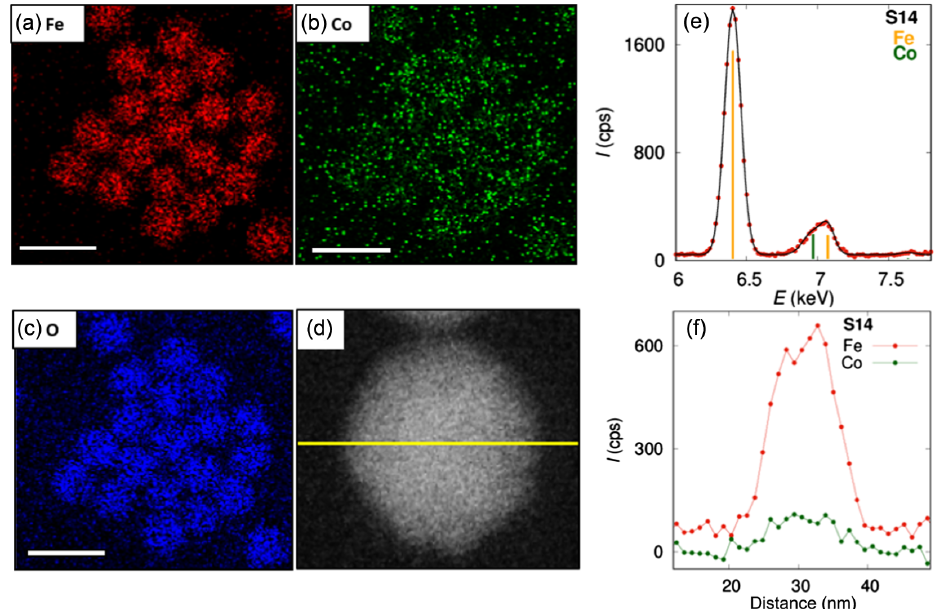
FIG. 11. (a) – (c) EDX map of the distribution of Fe, O, and Co over a region containing 19 – 20 particles (scale bars of EDX maps, 10 nm) with (e) spectra reconstructed from the indicated area. (f) EDX line scan over an arbitrarily selected particle, displayed in (d).